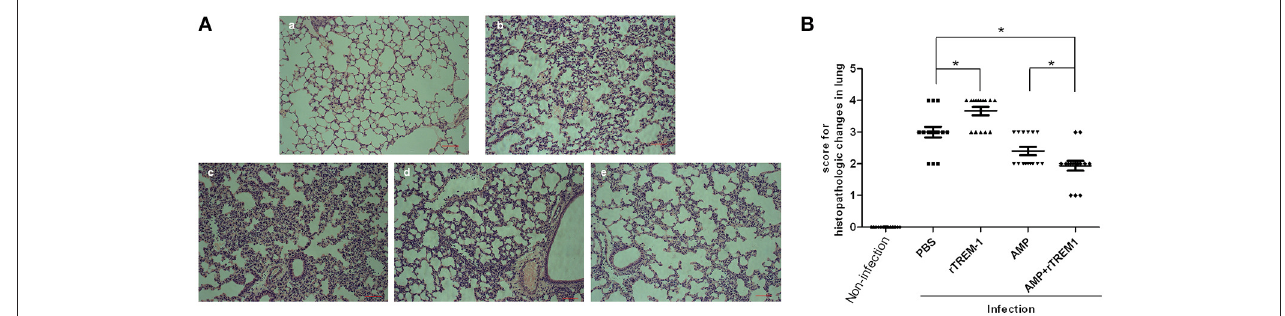
FIGURE 4 | The histopathological study on lungs of mice infected with highly virulent S. suis strain for 6h with different treatment. (A) The histopathologic evaluation of lung of mice treated with PBS (b), rTREM-1(c), ampicillin (d), and a combination of ampicillin and rTREM-1 (e) at 6h post infection with highly virulent S. suis strain. The mock infected mice were served as a control (a). The red line represents 20 µ m. (B) The comparasion of histopathologic changes of lung of mice infected with highly virulent S. suis strain with different treatment. Five areas were randomly selected from the every histopathologic section and then were scored based on the severity and inflammation. Scores 0, 1, 2, 3, and 4 represent normal, minimal, mild, moderate, and severe histopathologic changes. “ * ” represents p < 0.05 for the two selected